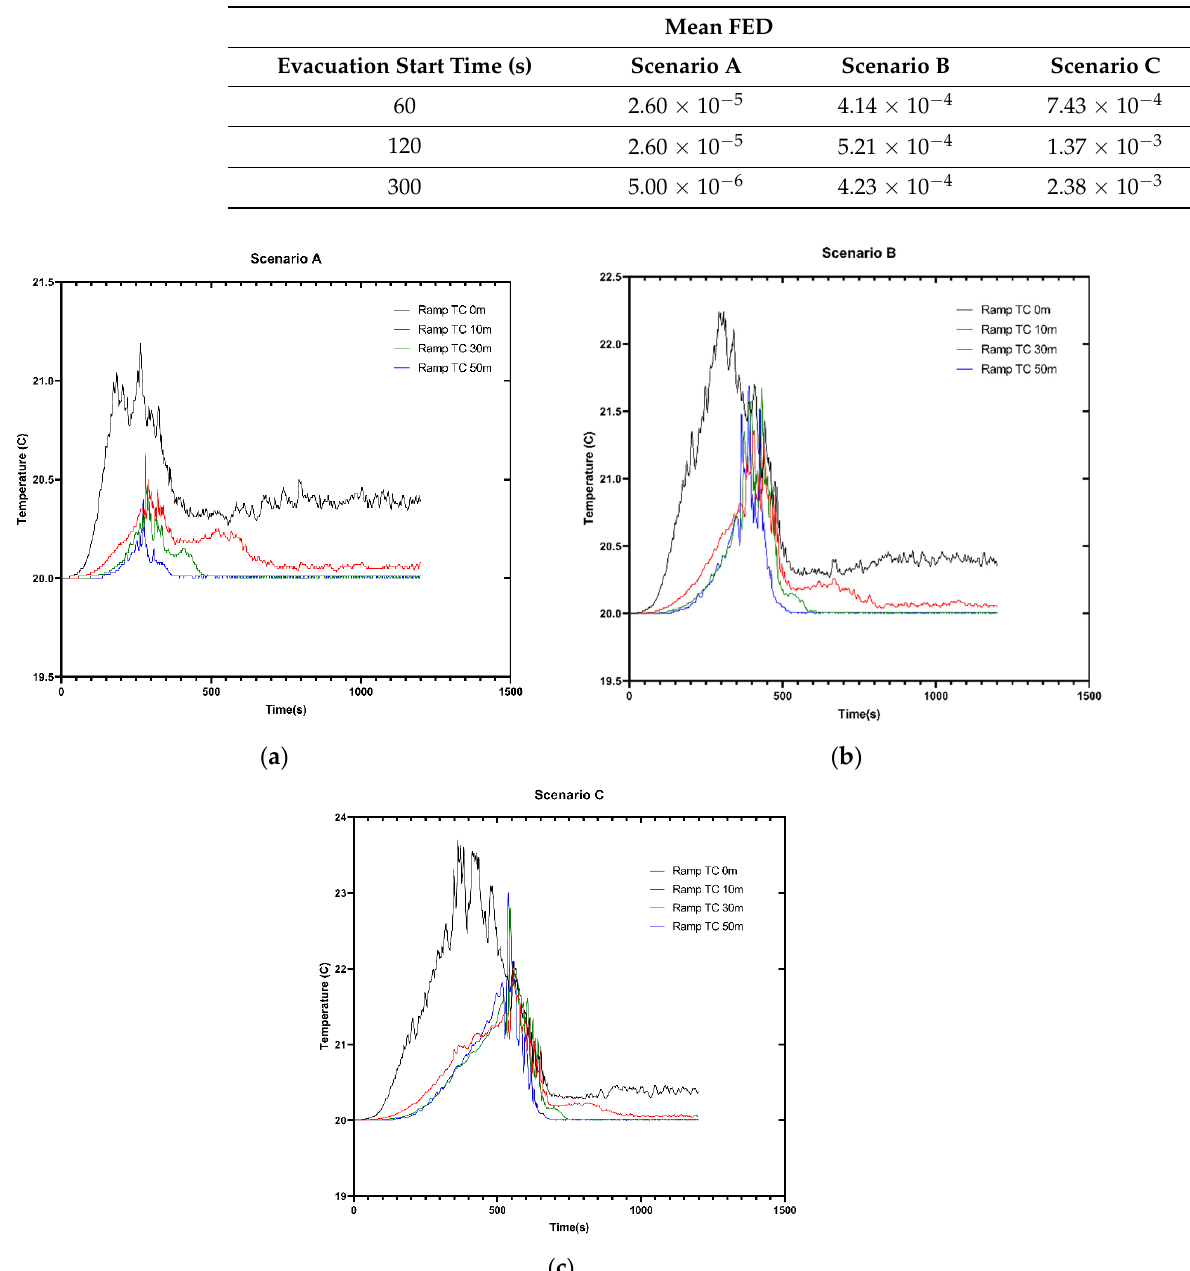
Figure 13. Lengthwise mean U velocity for Scenario A, upwind from the fire source. Table 2. Mean FED index for the three different scenarios and evacuation times.